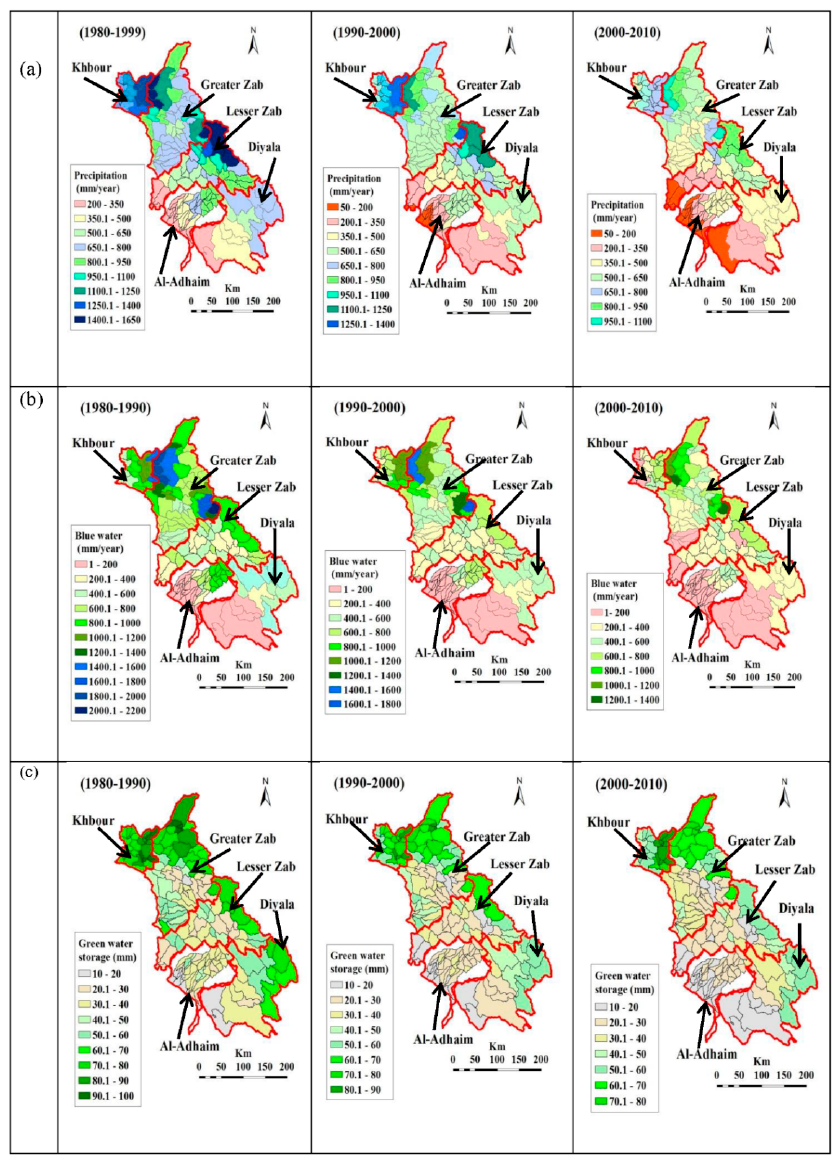
Figure 3. ( a ) Spatial distribution of precipitation, ( b ) Spatial distribution of blue water and ( c ) Spatial distribution of green water for the baseline period of 1980–2010 for northeast